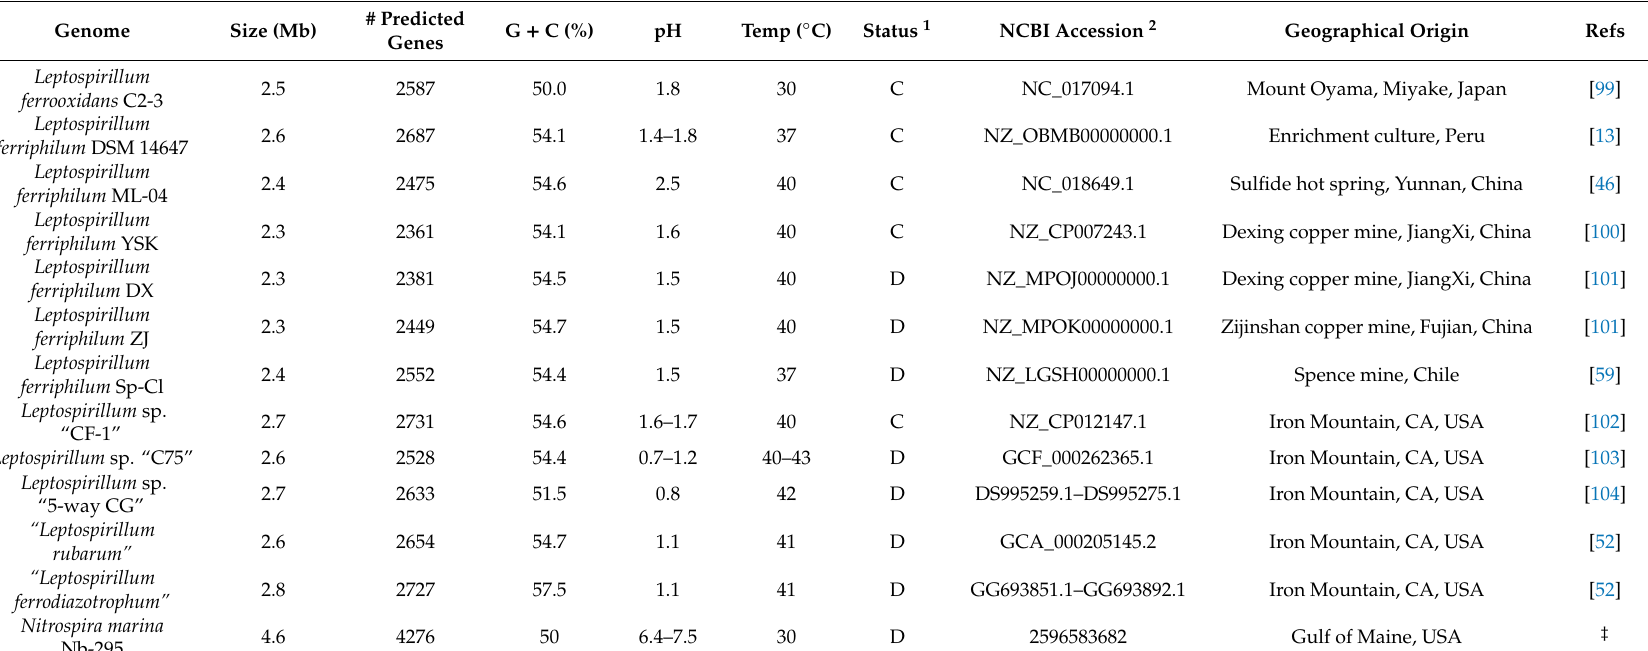
Table 1. Properties of organisms and their genomes used in this